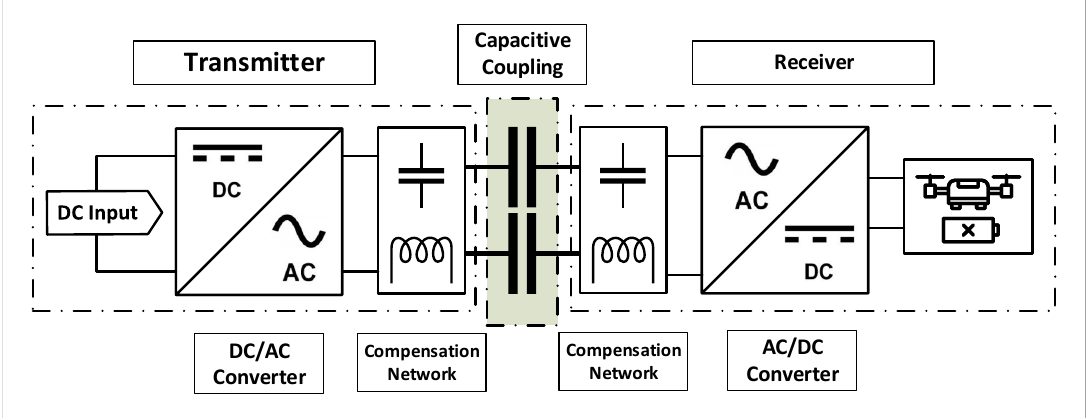
Figure 3. The structure of a typical capacitive coupling wireless power transfer (CCWPT) UAV charging system.